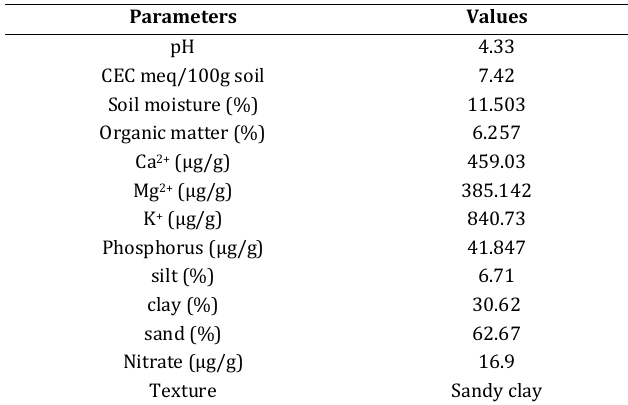
Table 1: The initial physico- chemical properties of the experimental soil